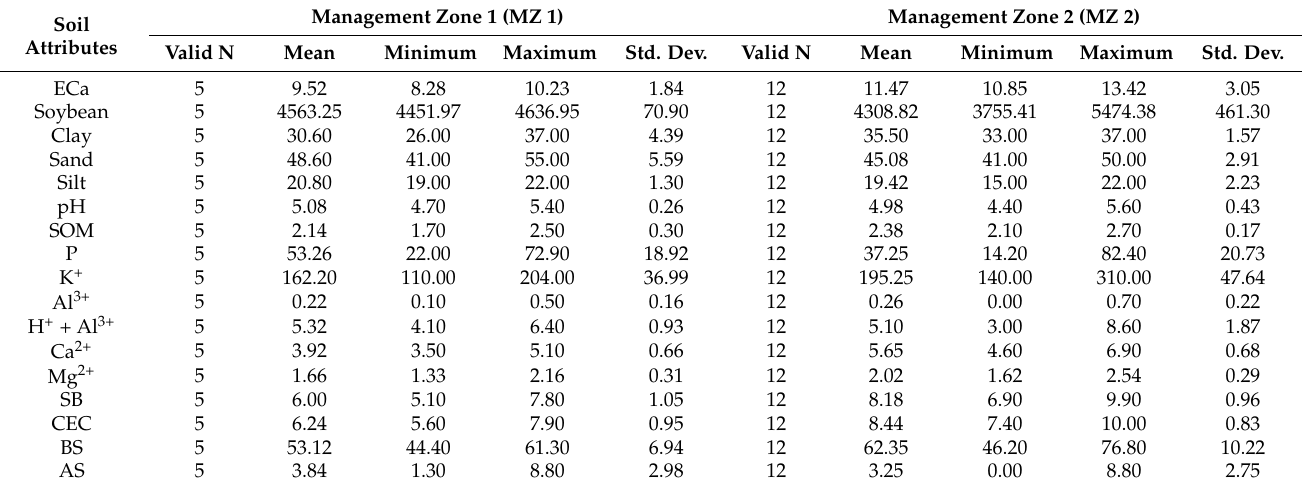
Figure 4. Spatial variability of ECa at the fields with clay ( A ) and sandy clay loam textures ( B ). Management zone maps (MZ1 and MZ2) and soil sampling points for clayey ( C ) and sandy clay loam fields ( D ). Table 2. Descriptive statistics of soil attributes for the sandy clay loam area (“Field SCL”).